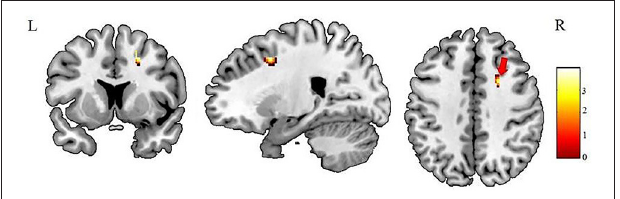
FIGURE 2 | Patients with IGE showed increased FA (refer to color scale) in the deep WM of the right prefrontal lobe (as indicated by the red arrow) compared